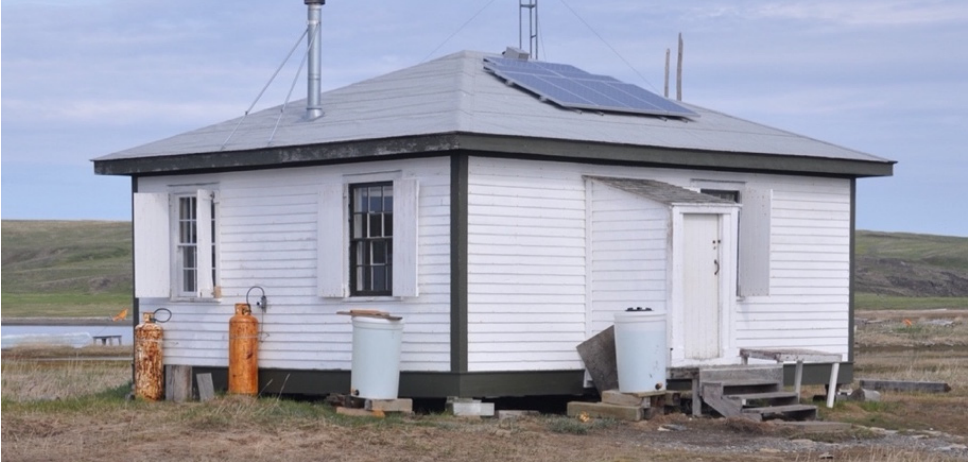
Figure 8. Signal House, Herschel Island—Qikiqtaruk.